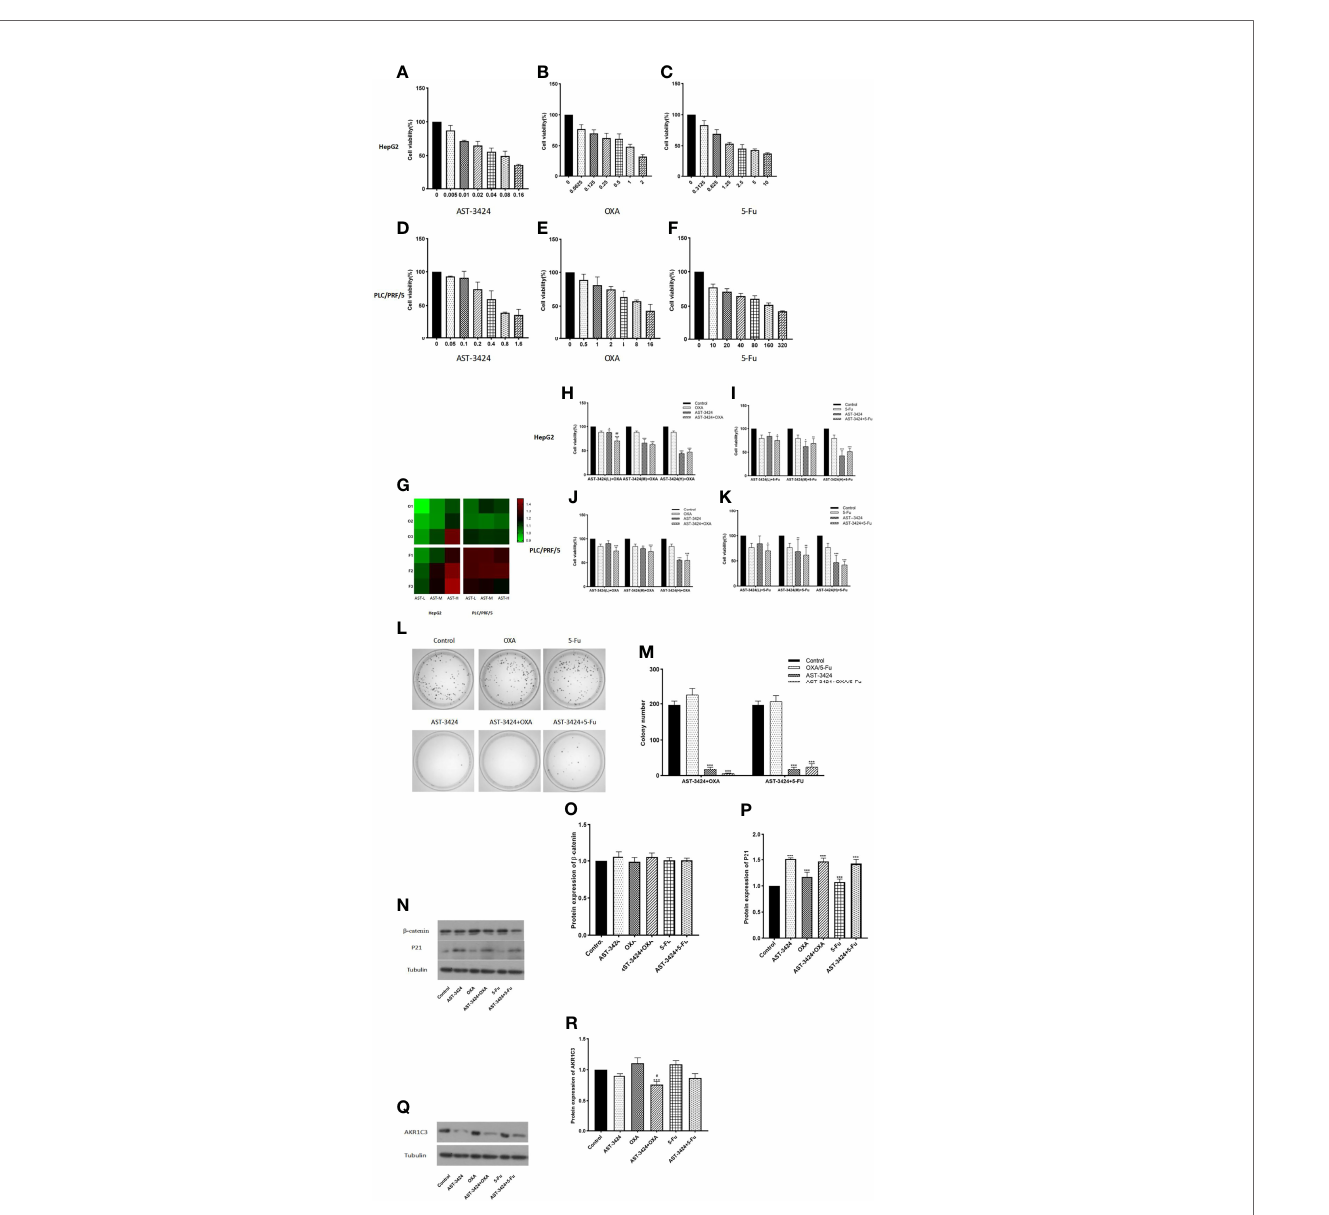
FIGURE 2 | The effect of treatment with AST-3424, OXA, or 5-Fu alone or in combination on cell proliferation and colony formation in HepG2 and PLC/PRF/5 cells. (A – C) Treatment with AST-3424 (0.005 – 0.16 m M), OXA (0.0625 – 2 m g/ml), or 5-Fu (0.3125 – 10 m g/ml) alone for 48 h in HepG2 cells. (D – F) Treatment with AST-3424 (0.05 – 1.6 m M), OXA (0.5°16 m g/ml), or 5-Fu alone (10 – 320 m g/mL) for 48 h in PLC/PRF/5 cells. (G) Heat graph of coef fi cient of drug interaction (CDI) values in HepG2 and PLC/PRF/5 cells [AST-3424 (T1-H 0.005 m M; T2-H 0.01 m M; T3-H 0.05 m M) combined with OXA (O1 0.02 m g/ml; O2 0.15 m g/ml; O3 1 m g/ml) or 5-Fu (F1 0.3125 m g/ml; F2 0.625 m g/ml; F3 1.25 m g/ml) for 48 h in HepG2 cells and AST-3424 (T1-P 0.1 m M; T2-P 0.3 m M; T3-P 0.6 m M) combined with OXA (O1 0.5 m g/ml; O2 3 m g/ml; O3 9 m g/ml) or 5-Fu (F1 2 m g/ml; F2 20 m g/ml; F3 160 m g/ml) for 48 h in PLC/PRF/5 cells)]. A CDI >1 indicates antagonism; CDI <1 means synergy; CDI = 1 indicates additive effects. (H, I) Cell proliferation ability was assessed after HepG2 cells were treated with AST-3424-L (0.005 m M), AST-3424-M (0.01 m M), AST-3424-H (0.05 m M), OXA (0. 02 m g/ml), and 5-Fu (0.3125 m g/mL) alone or in combination for 48 h. (J, K) Cell proliferation ability was assessed after PLC/PRF/5 cells were treated with AST-3424-L (0.1 m M), AST-3424-M (0.3 m M), AST-3424-H (0.6 m M), OXA (0.5 m g/ml), and 5-Fu (2 m g/ml) alone or in combination for 48 h. (L, M) The inhibiting effects on colony formation following monotherapy or combination therapy were shown in HepG2 cells, and the colony numbers